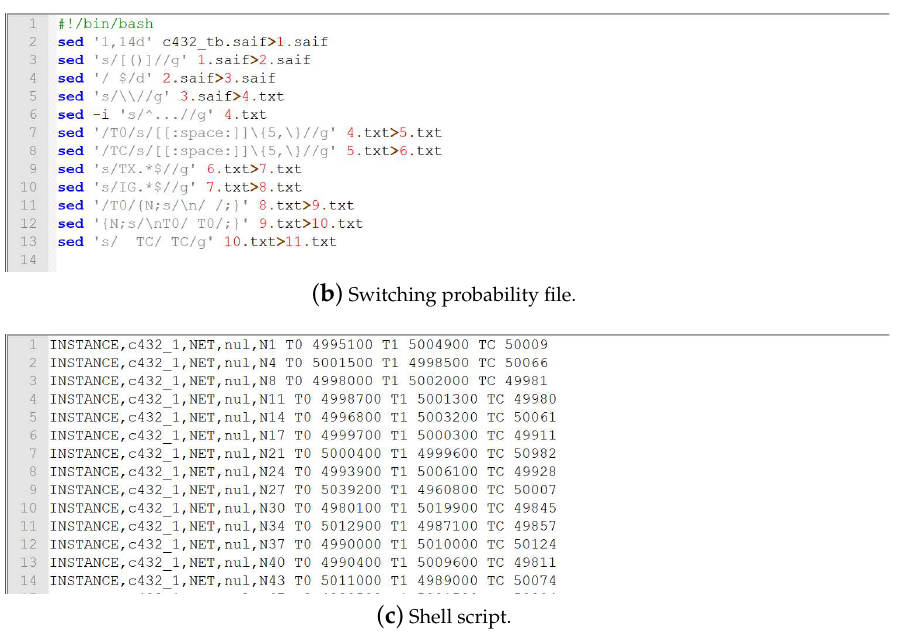
Figure 10. Fragments of the files and scripts utilized in the minimum working example